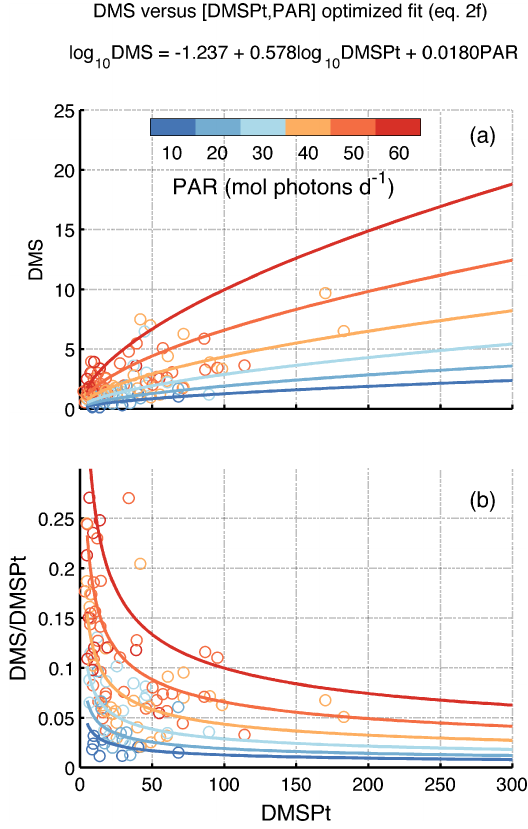
Figure 3. Relationship between DMS, DMSPt and PAR as rep- resented in the DMS SAT algorithm. (a) DMS vs. DMSPt and (b) DMS / DMSPt ratio vs. DMSPt, as a function of PAR. Colored circles represent the medians of in situ data binned by Longhurst province and month, and lines correspond to the model predictions. PAR levels are indicated in the color